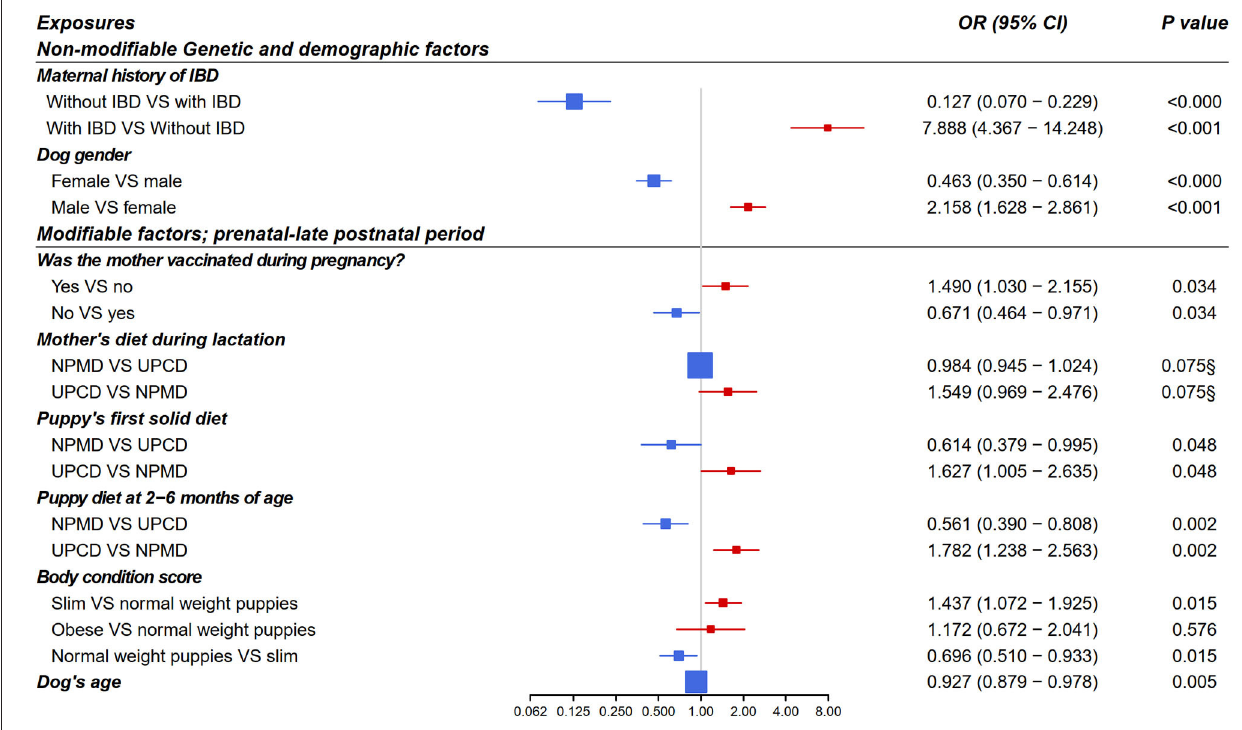
FIGURE 4 | Forest plot of odds ratios for the association of early life exposures and inflammatory bowel disease in adult dogs based on multivariate logistic regression analysis ( n = 7015, adjusted for dog age). Included dogs for each model: model 1 ( n = 1976), model 2 ( n = 1022), model 3 ( n = 2218), model 4 ( n = 1830), and model 5 ( n = 1532). Modifiable exposures included models from 2 to 5 as following model 2: prenatal period, model 3: neonatal period, model 4: early postnatal period, model 5: late postnatal period. OR, odds ratio; CI, confidence interval; IBD, inflammatory bowel disease; NPMD, non-processed meat based diet; UPCD, ultra-processed carbohydrate based diet; VS, versus. § non-significant p >